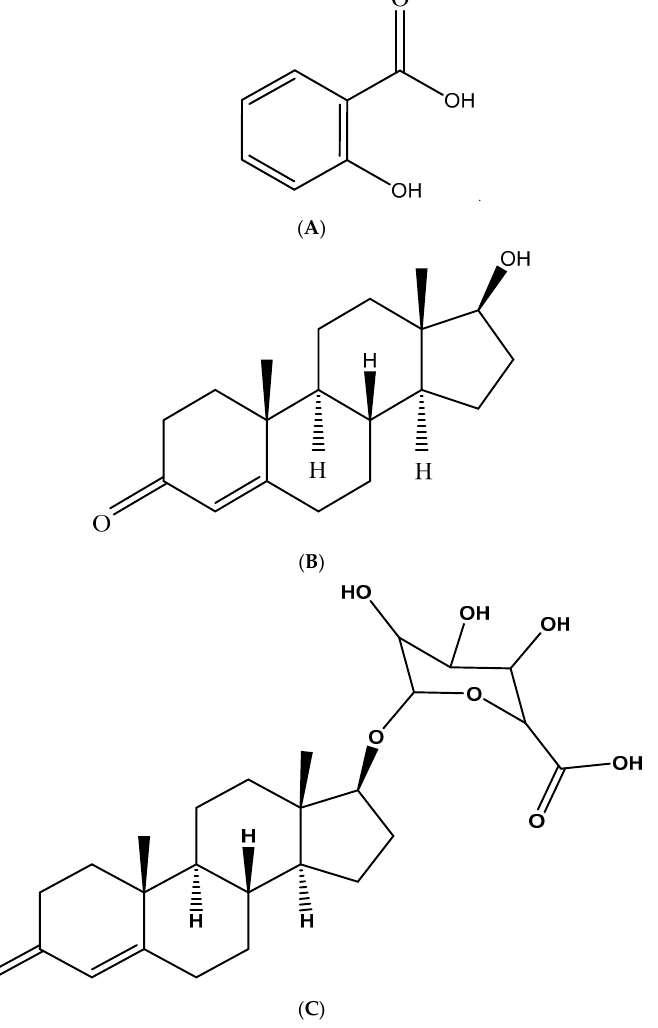
Figure 1. Chemical structures of: salicylic acid ( A ), testosterone ( B ), and testosterone glucuronide ( C ).